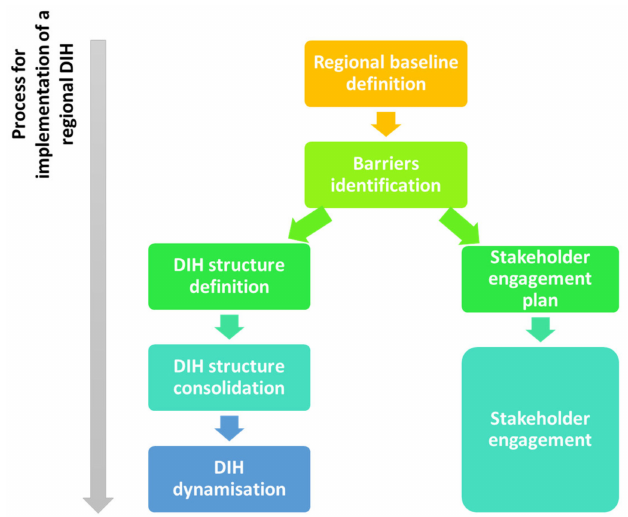
Figure 1. Process methodology for implementation of a regional DIH.